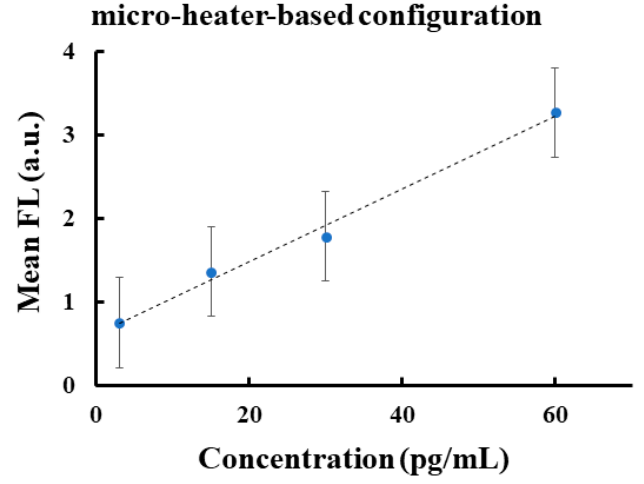
Figure 3. Plot of regression of linear range of mean fluorescence as a function of the concentration in the case of the micro-heater-based configuration.